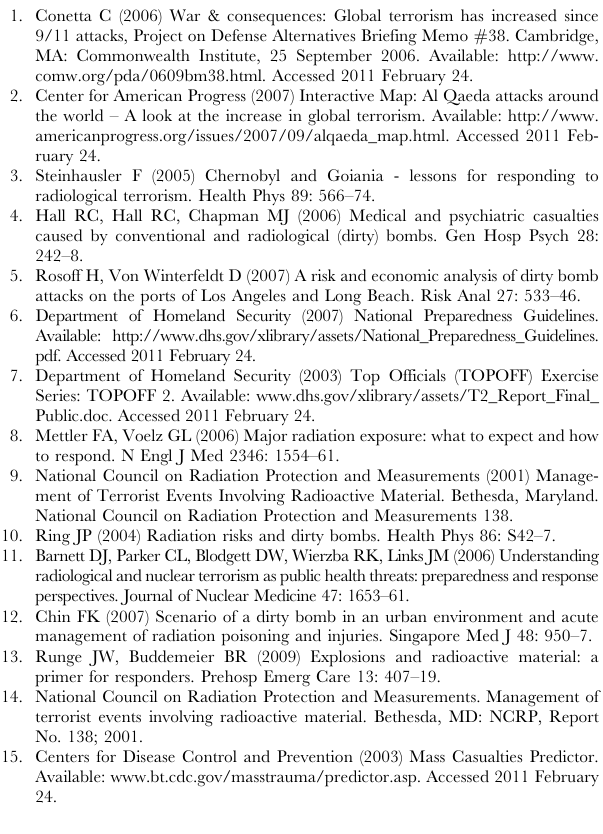
Table S1 Associations between demographic character- istics and self-reported WTR to a radiological dispersal device emergency. Table S2 Associations between attitudes/beliefs and self-reported WTR to a radiological dispersal device emergency. Table S3 Associations between attitudes/beliefs and self-reported WTR to a radiological dispersal device emergency compared to those not willing to